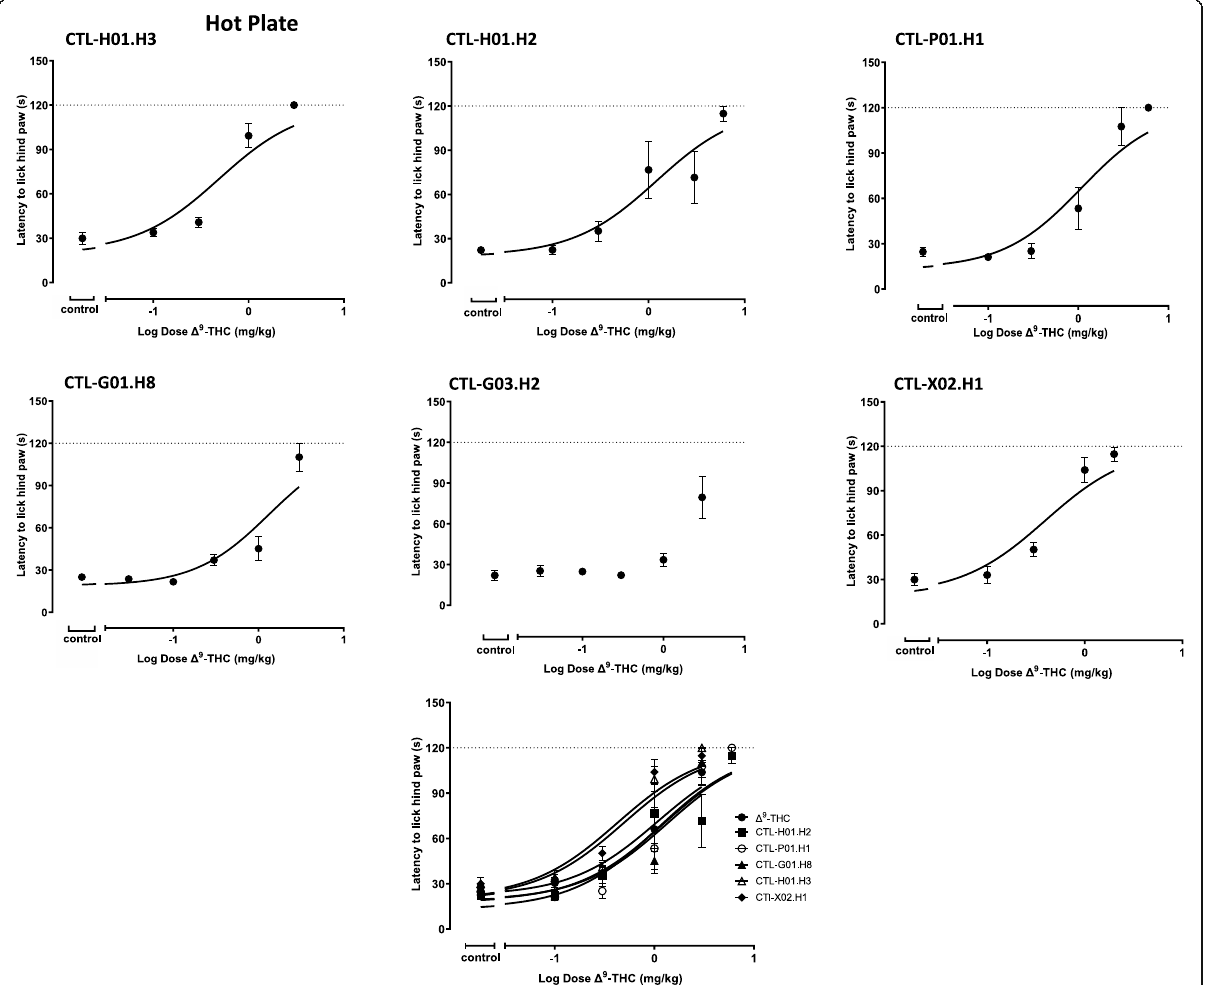
Fig. 4 The effects of cannabis cultivar extracts were examined in the standard hot plate assay 5 – 10 min post-dose. Mice were intravenously dosed with control (vehicle) or CTL-H01-H3 (0.1, 0.3, 1 and 3 mg/kg) (n = 10 per group), CTL-H01-H2 (0.1, 0.3, 1, 3 and 6 mg/kg) (n = 6 per group), CTL-P01-H1 (0.1, 0.3, 1, 3 and 6 mg/kg) (n = 6 per group with 1 animal excluded from 6 mg/kg), CTL-G01-H8 (0.03, 0.1, 0.3, 1 and 3 mg/kg) (n = 6 per group), CTL-G03-H2 (0.03, 0.1, 0.3, 1 and 3 mg/kg) (n = 6 per group) or CTL-X02-H1 (0.1, 0.3, 1, and 2 mg/kg) (n = 10 per group) cannabis cultivar extract. The curves have been summarized on the same set of axes to facilitate visual comparisons. Data are presented as the mean ± SEM. Data were fit using a 3 parameter log (agonist) vs. response non-linear regression model. Dosing was based on the Δ 9 -THC content of